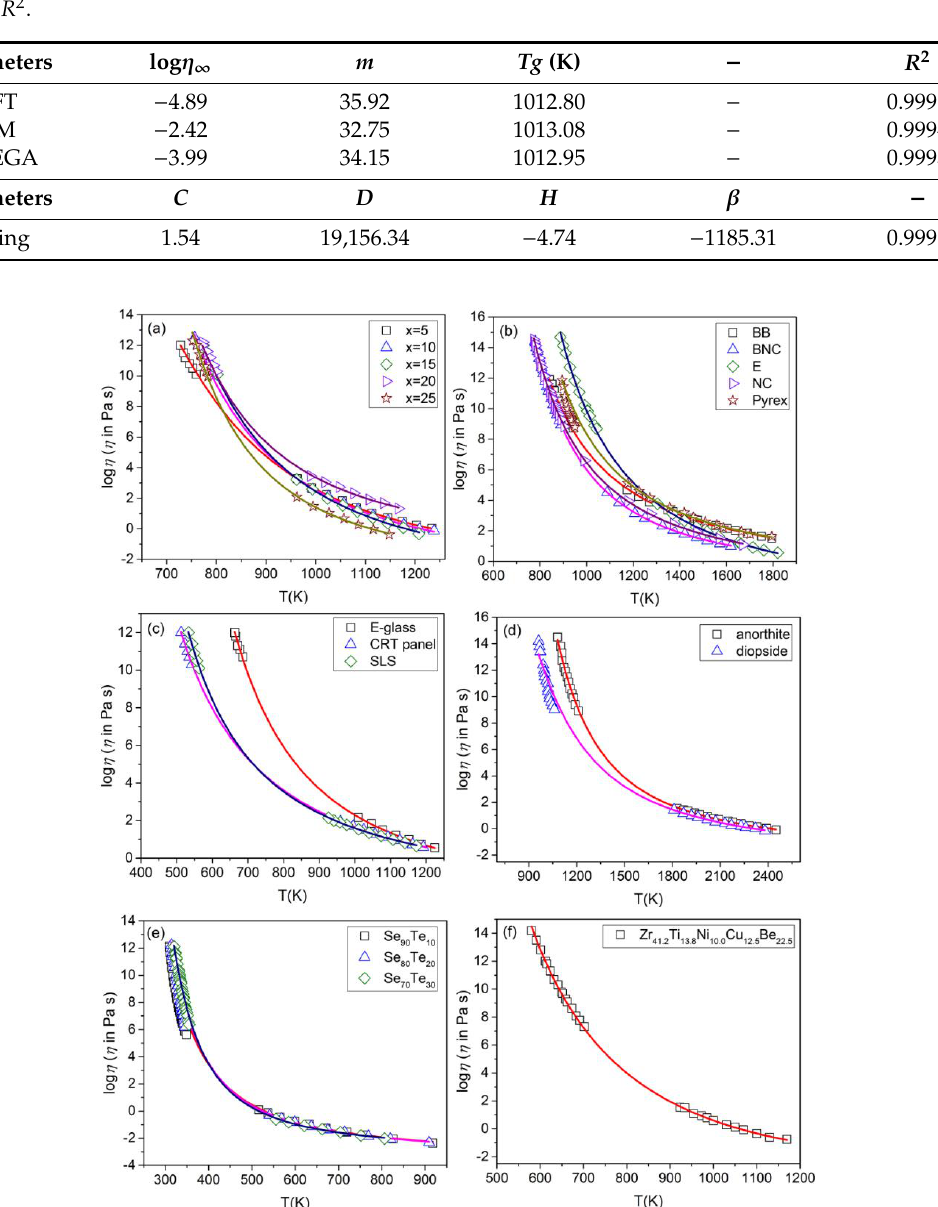
Figure 4. Comparison between predicted values and experimental viscosity values of different glasses: ( a ) xNa 2 O-10CaO-(89-x)B 2 O 3 -1Fe 2 O 3 (x = 5, 10, 15, 20, 25); ( b ) borosilicate melts; ( c ) silicate glass foam; ( d ) anorthite and diopside; ( e ) Se 90 Te 10 , Se 80 Te 20 and Se 70 Te 30 glass-forming system; ( f ) metallic glass-Zr 41.2 Ti 13.8 Ni 10.0 Cu 12.5 Be 22.5 . Table 3. R 2 of the predictions.